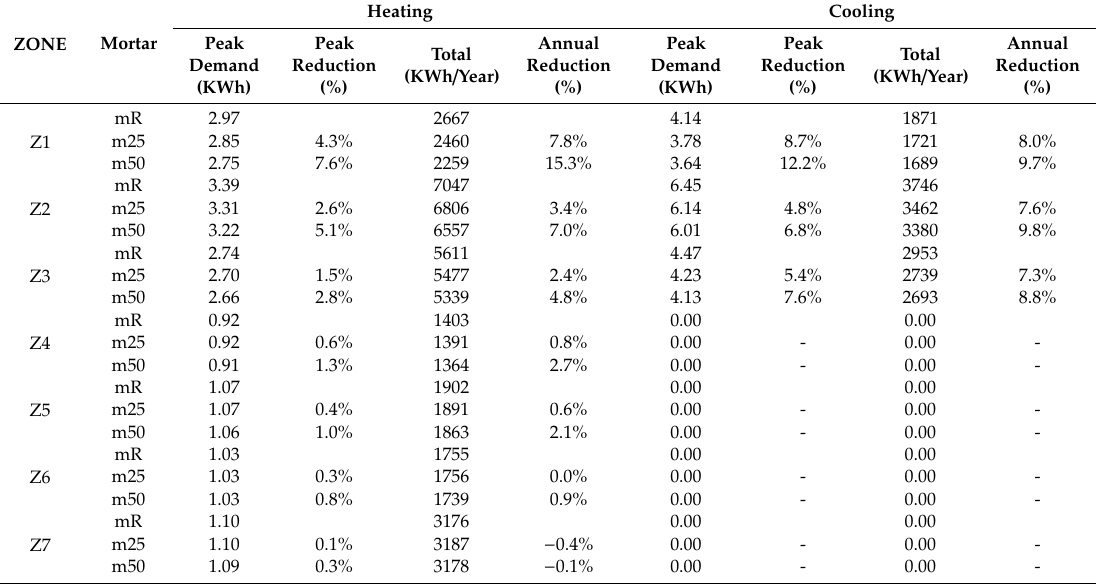
Table 8. Heating and cooling demand and peak by zones, depending on mortar